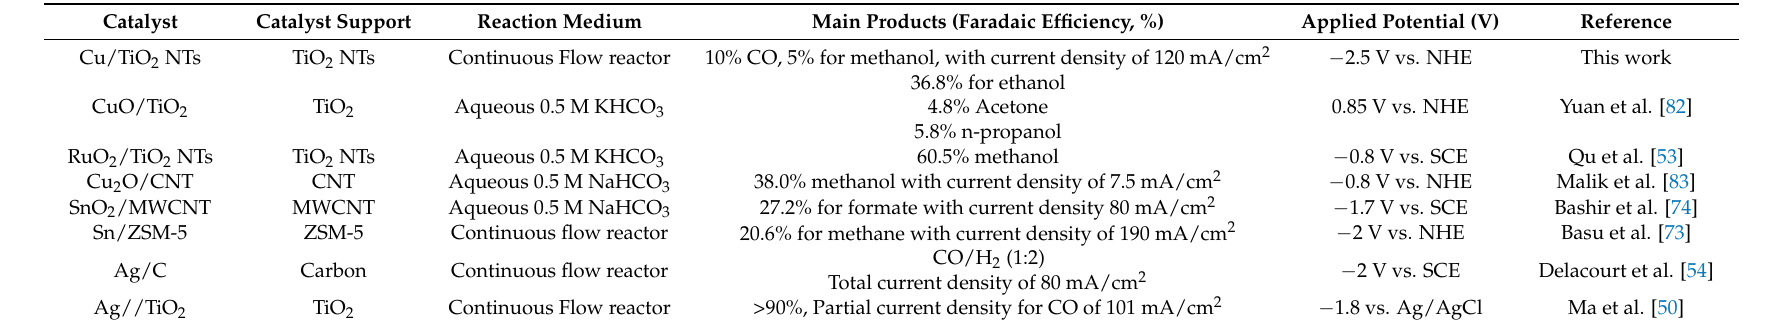
Table 2. Comparison of the representative research works on supported electrocatalysts for the electrochemical reduction of CO 2